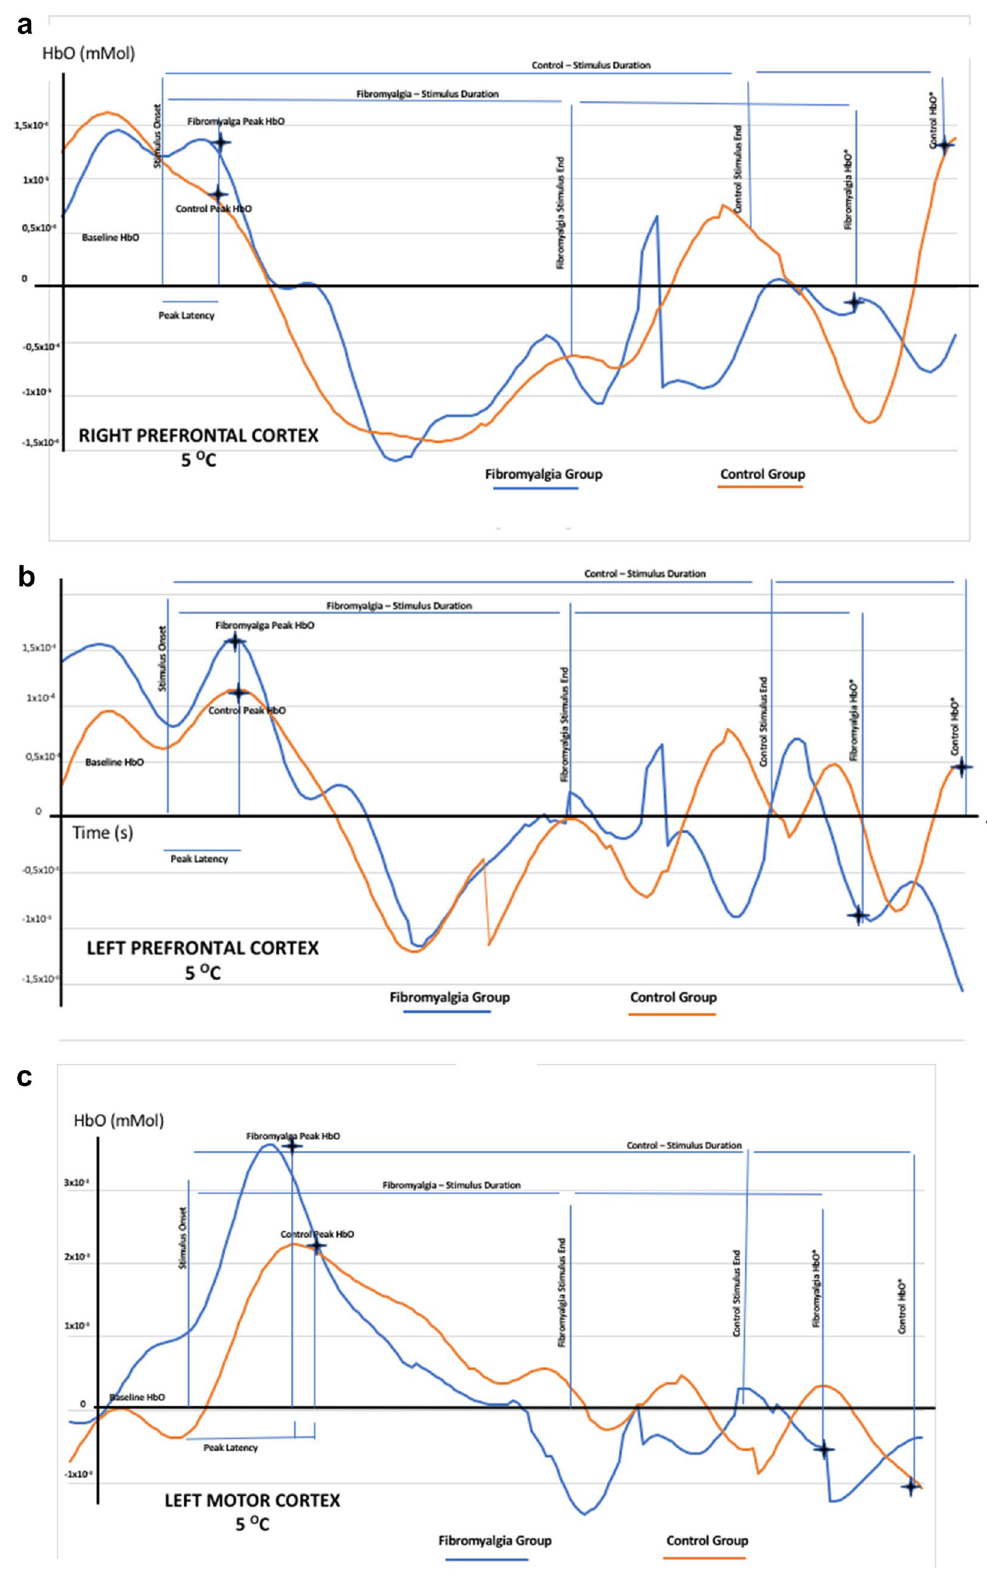
Figure 3. Representative waveforms from cortical activation at right PFC ( A ); left PFC ( B ) and left motor cortex ( C ). Figures shows waveforms from cortical activation of an illustrative subject with fibromyalgia or one control. They showed waveforms of oxyhemoglobin (HbO) by fNIRS upon to primary (25 °C) or secondary (5 °C) stimulus. The figure presents both sides left and right prefrontal cortex (PFC). ( A ) Peak latency represents the maximum peak (time in seconds) and HbO millimolar. ( B ) (ΔHbO) [steady-state HbO before thermal primary or secondary stimuli onset minus the absolute value of peak HbO] (mM). ( C ) The cortical activation 15 s after thermal stimuli end by the variability of absolute HbO concentration [the difference between the delta value of HbO (Δ-HbO) 15 s from thermal stimuli end and Δ-HbO before thermal stimuli onset